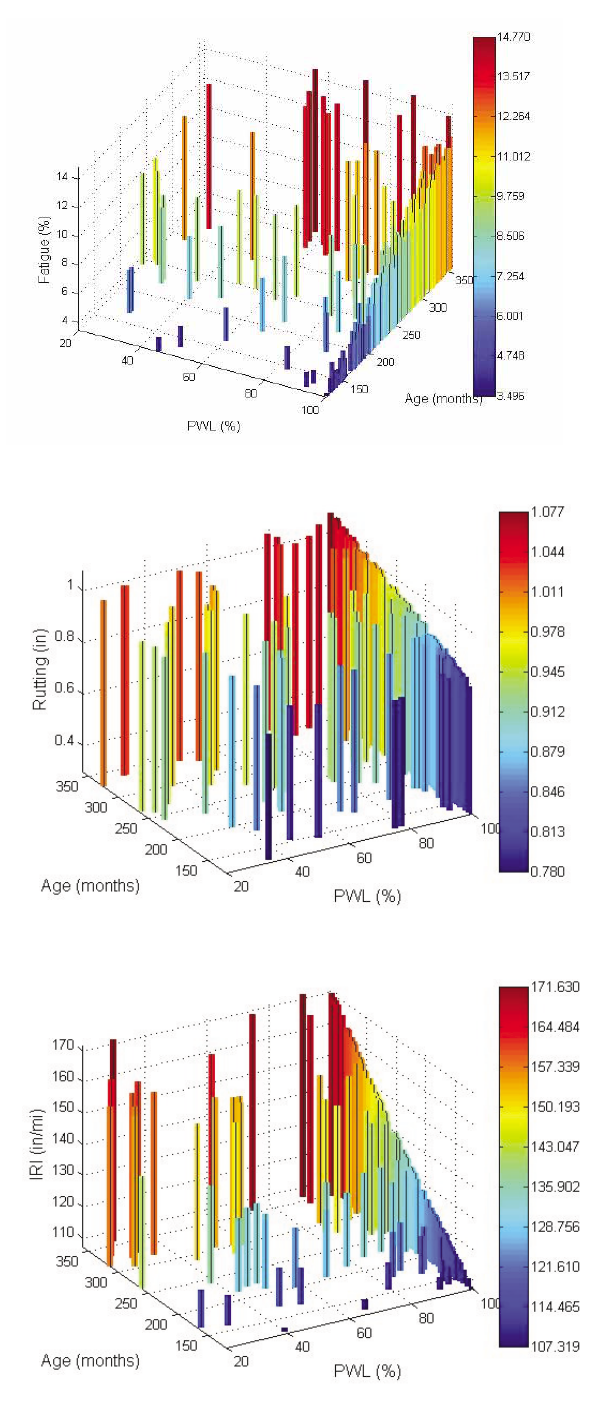
Fig. 3. Pavement performance versus PWL (in-situ air voids) for mix 1 using MEPDG